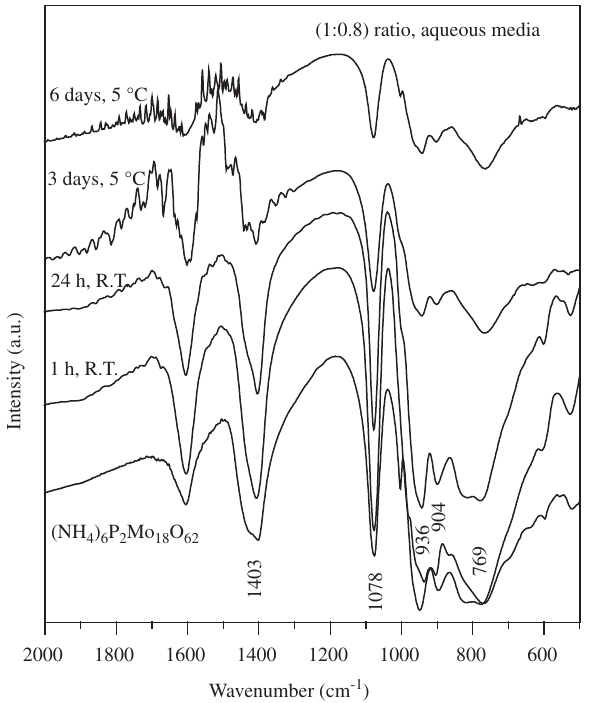
Figure 3. Infrared spectra of the (NH terials obtained through the ion exchange of the salt in contact with (1:0.8) salt:resin weight ratio and variable time and temperature of exchange in aqueous media.